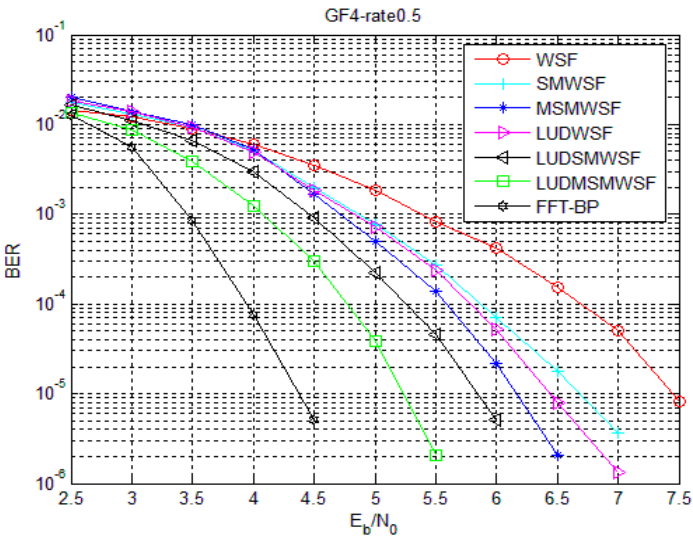
Figure 7. Comparison of improved algorithms under Code 1.